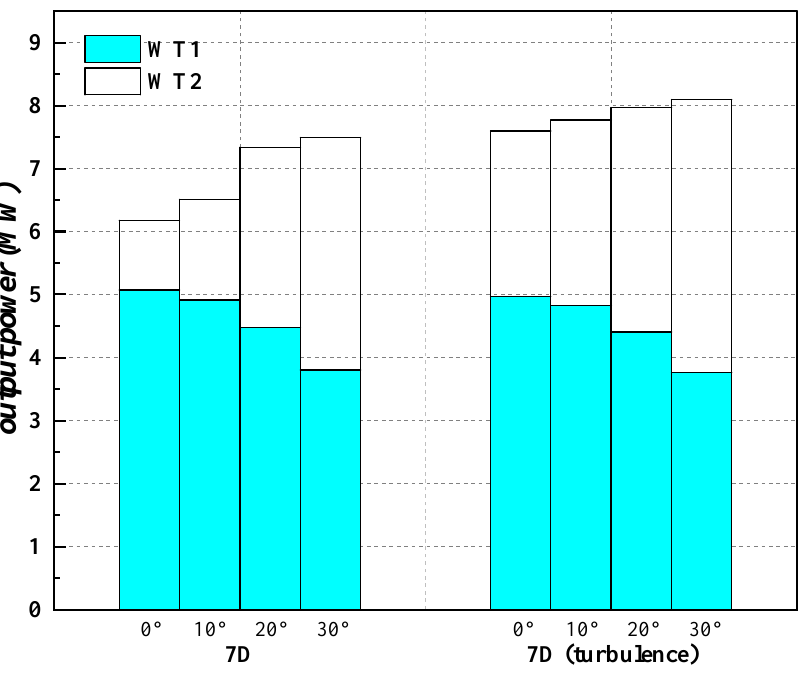
Figure 19. The average output power of the turbines in the ABL wind field compared with uniform inflow under 7D